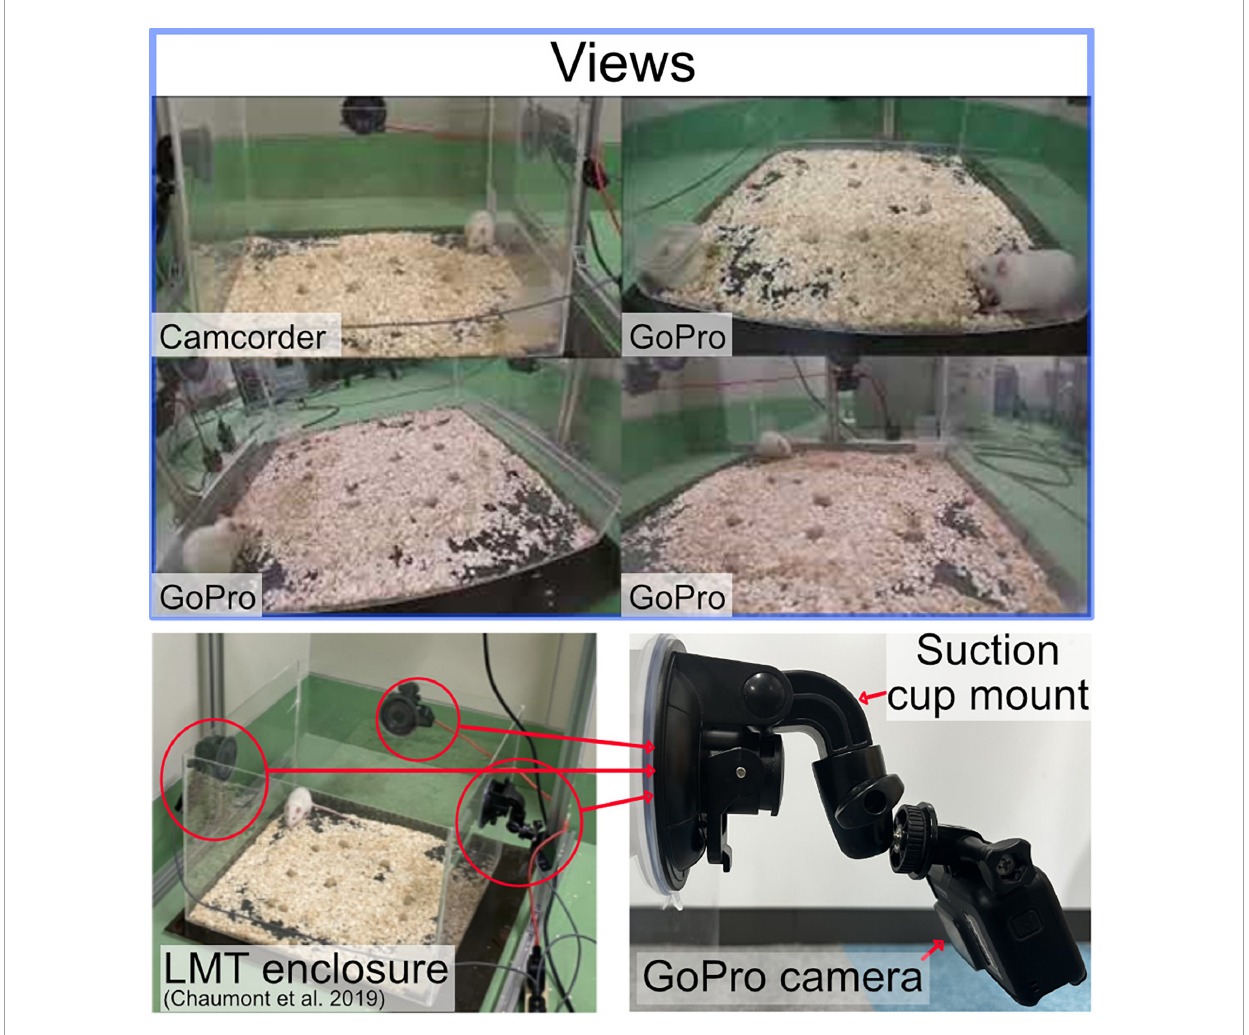
FIGURE1 Top : the rat being depicted from different perspectives. Left bottom : the open source LMT acrylic enclosure. Bottom right : GoPro camera attached by a suction cup